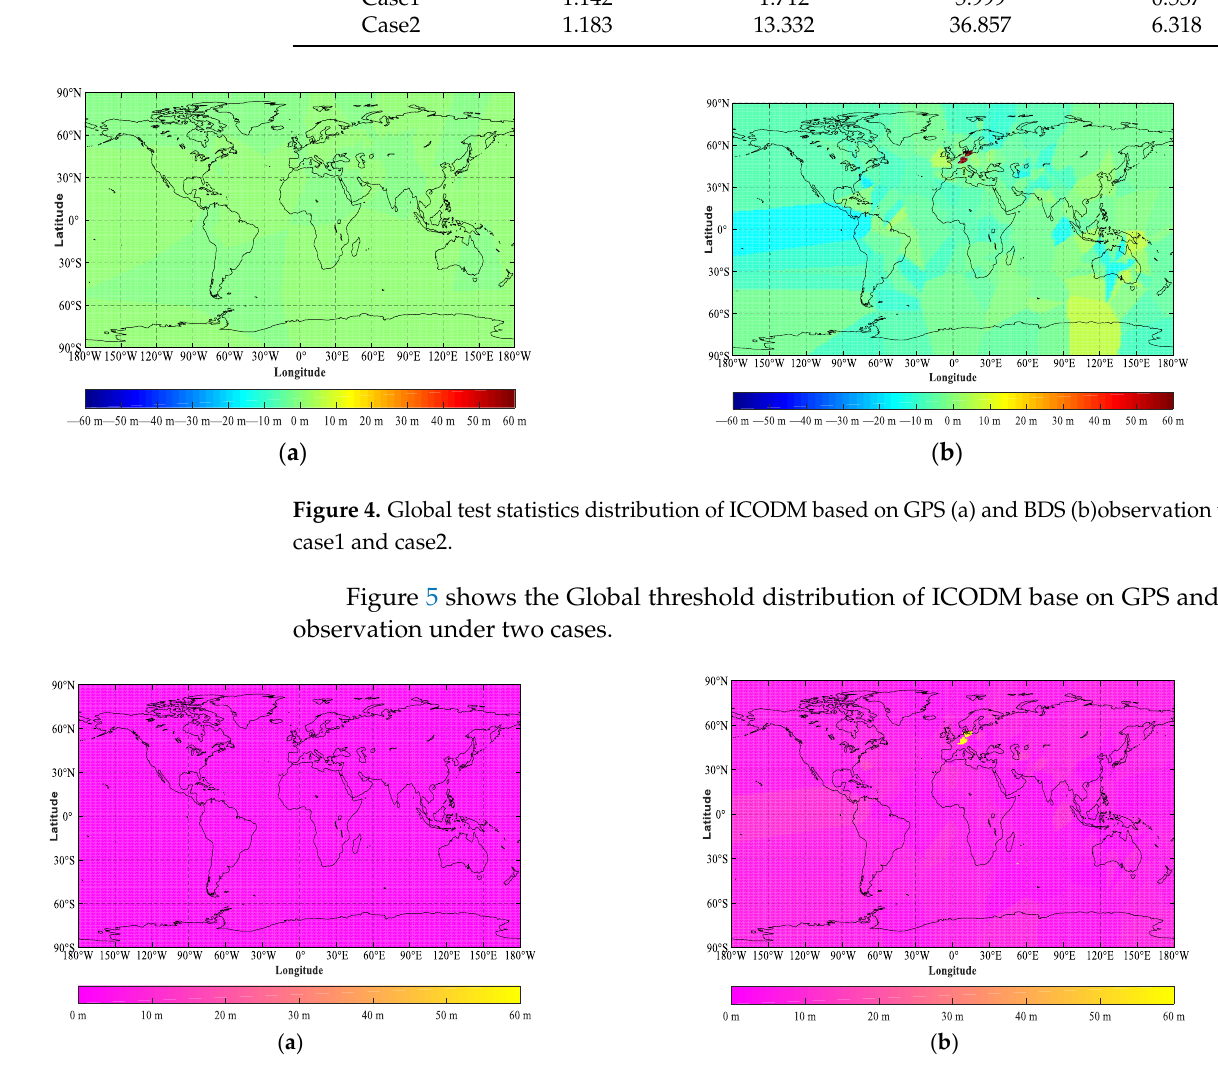
Figure 5. Global threshold distribution of ICODM based on ( a ) GPS and ( b ) BDS observation under case1 and case2.